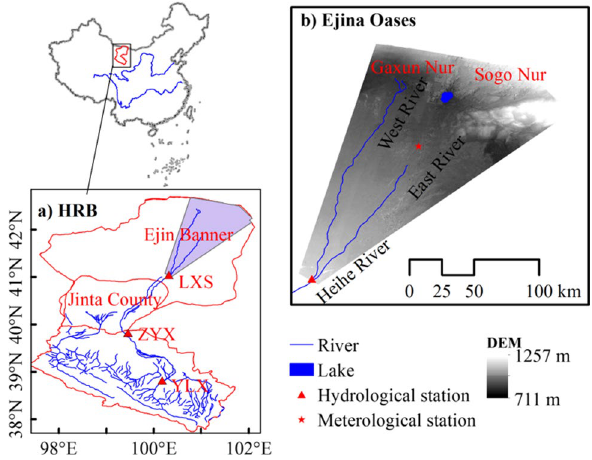
Fig. 1 Study area of Ejina Oases in downstream of Heihe River basin in northwest